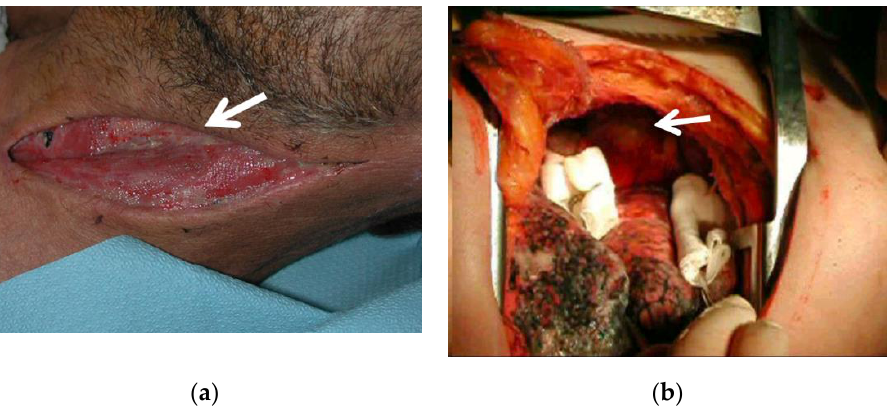
Figure 2. In all cases, mediastinum drainage via thoracotomy was performed after neck drainage via cervicotomy: ( a ) intra-operative field during cervicotomy showing purulent material (white arrow) coming from the cervical fasciae; ( b ) intra-operative field during thoracotomy, showing yellowish purulent collection (white arrow) in the anterior mediastinum (the lung has been retracted). Overall, 10 right lateral thoracotomies and 5 left lateral thoracotomies were per- formed. During thoracotomy, after opening the mediastinal pleura, mediastinal debride- ment and washing with intra-operative disinfectant solutions was carried out, as well as locations; material was collected for microbiological examination and large bore chest tubes were placed.